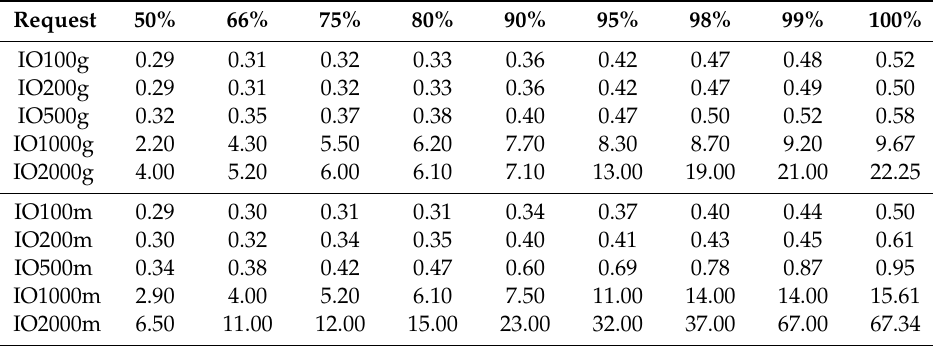
Table 5. Requests per second (total and for different SOS request) with different concurrent data consumers and WSGI applications for the test case of a medium size monitoring network (case A). Rate of failure ( ρ ) is reported when errors have been detected. Table 6. Percentage of insertObservation requests completed within given times (in seconds) for the di ff erent configuration of concurrent users and WSGI server (case